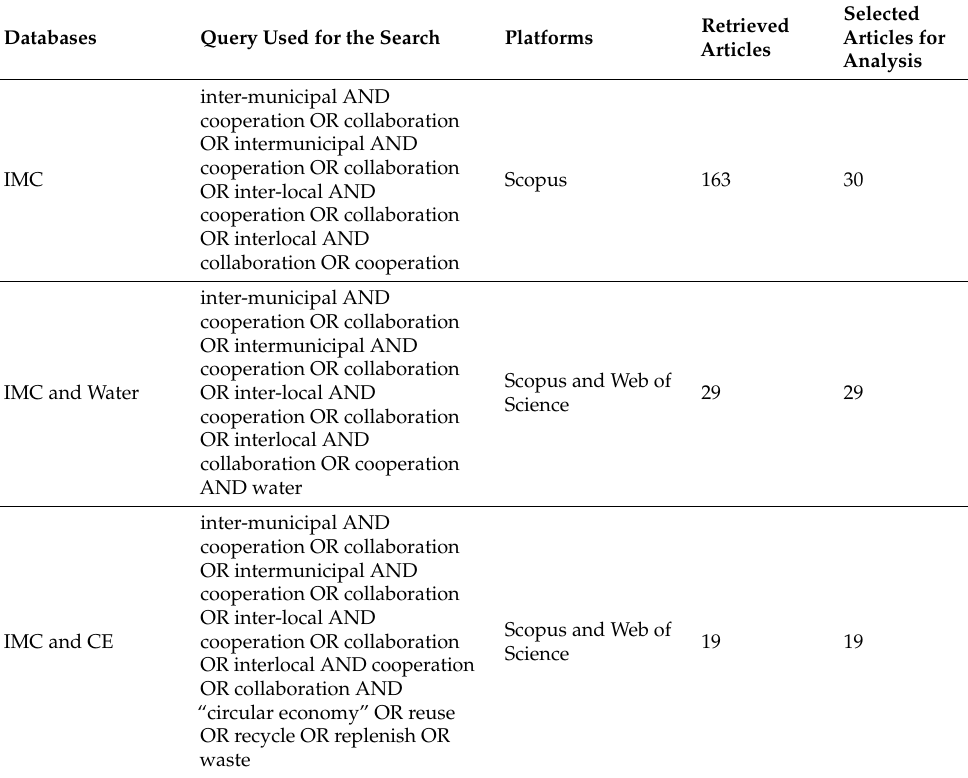
Table 1. The databases and search criteria of the literature review.